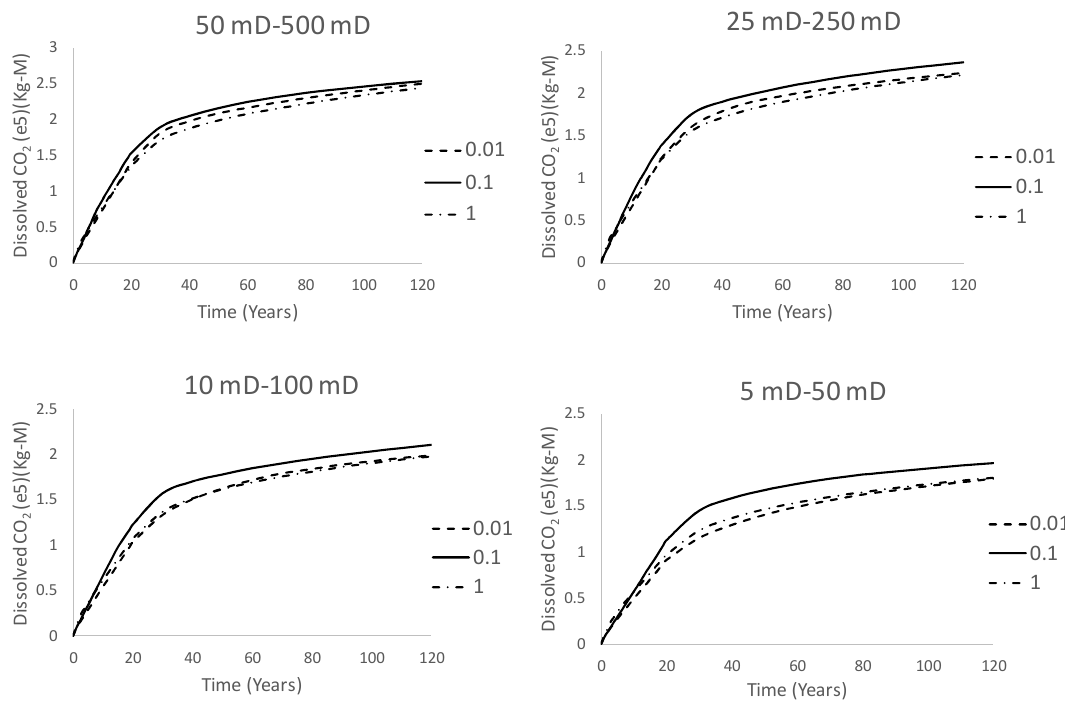
Figure 5. Control of absolute permeability on K v / K h ratio on CO 2 dissolution in brine (by changing K v ).